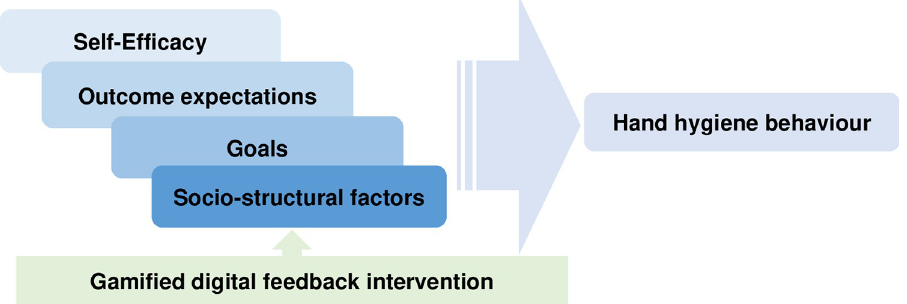
Fig 4. The application of the SCT using the live feedback